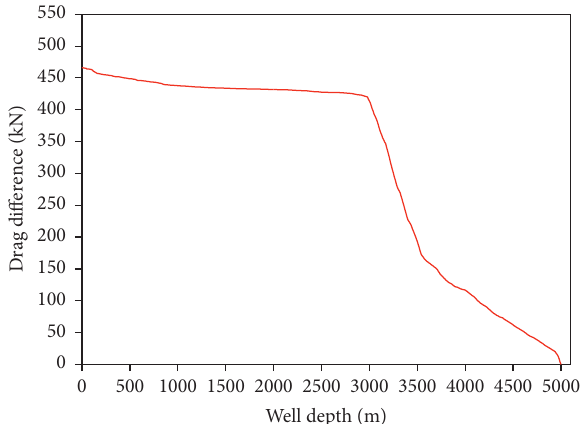
Figure 9: Drag difference between BHA 1 and BHA 2.